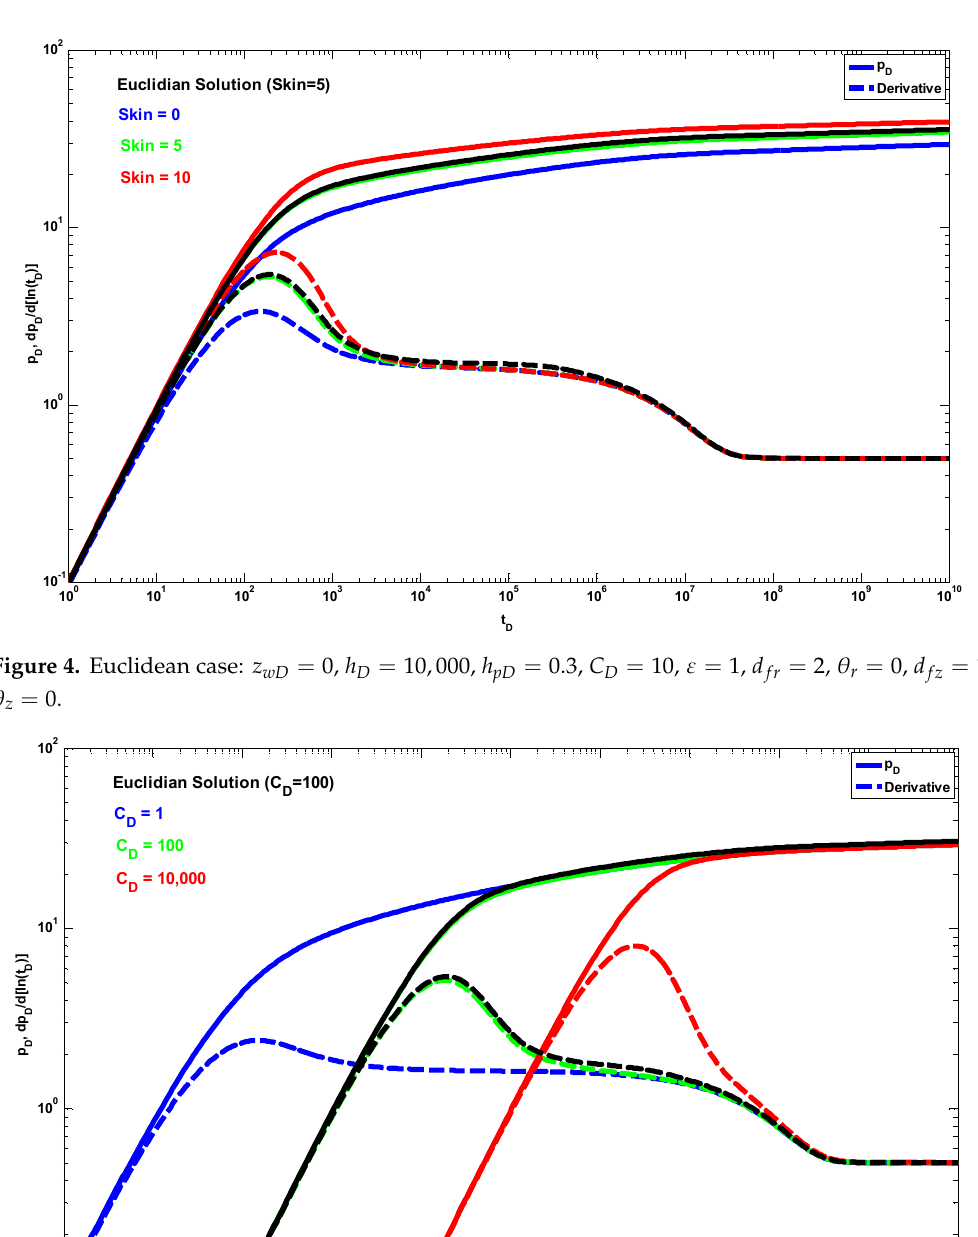
Figure 3. Euclidean case: 𝑧 (cid:3050)(cid:3005) = 0 , ℎ (cid:3005) = 10,000 , 𝑆 = 0 , 𝐶 (cid:3005) = 10 , 𝜀 = 1 , 𝑑 (cid:3033)(cid:3045) = 2 , 𝜃 (cid:3045) = 0 , 𝑑 (cid:3033)(cid:3053) = 1 , 𝜃 (cid:3053) = 0 .